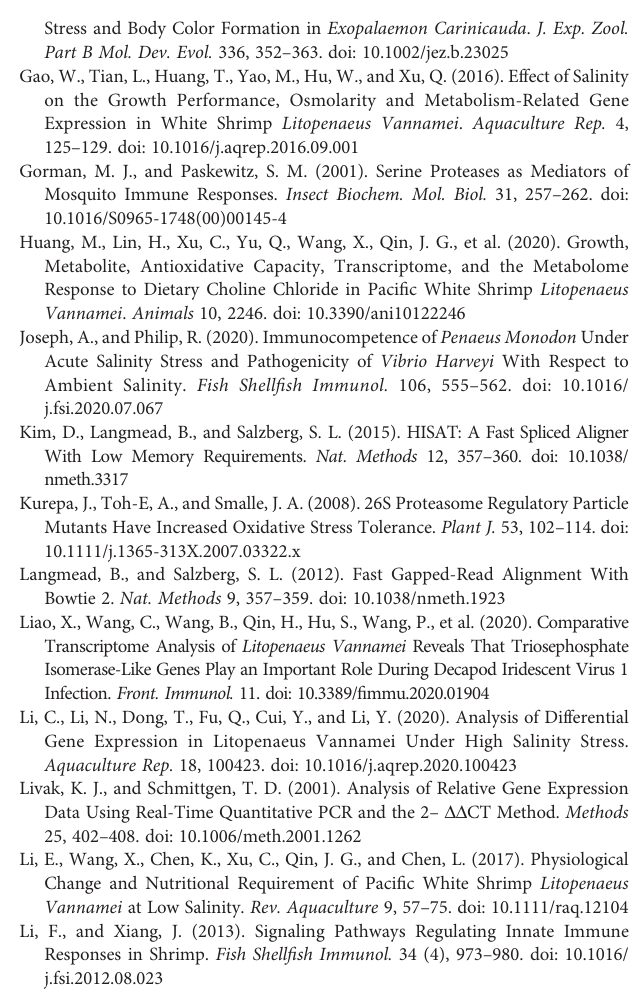
Supplementary Figure 1 | Survival rate of different families under high-salinity stress in L. vannamei . The black columns represent families selected for comparative transcriptome analysis. Supplementary Table 1 | Primer sequences and annealing temperature used for RT-qPCR. Supplementary Table 2 | Summary of RNA sequencing data